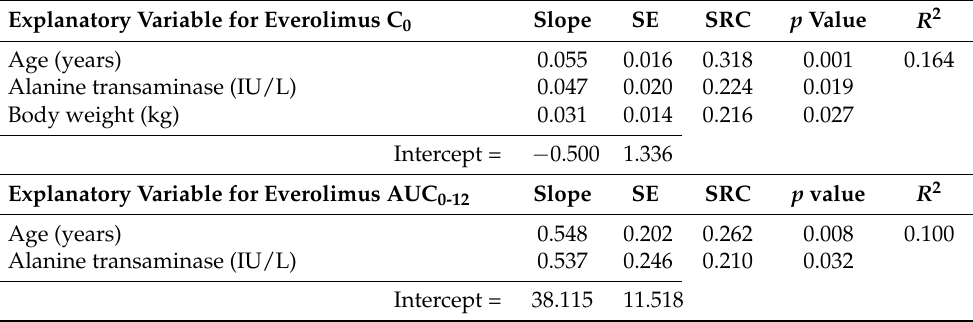
Table 4. Stepwise multiple regression analysis of explanatory variables for everolimus dose-adjusted C 0 and AUC 0-12